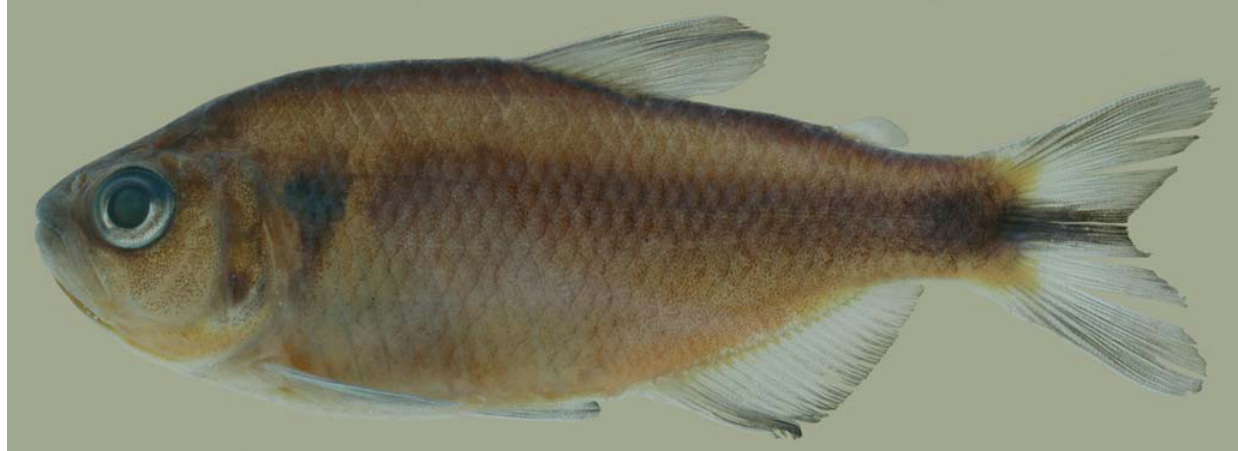
Fig. 1. Astyanax xavante , MZUSP 100375, 57.3 mm SL, holotype, from creek tributary of the córrego Avoadeira, rio Araguaia basin (approx. 15 o 53’S 52 o 15’W), Barra do Garças, Mato Grosso, Brazil.